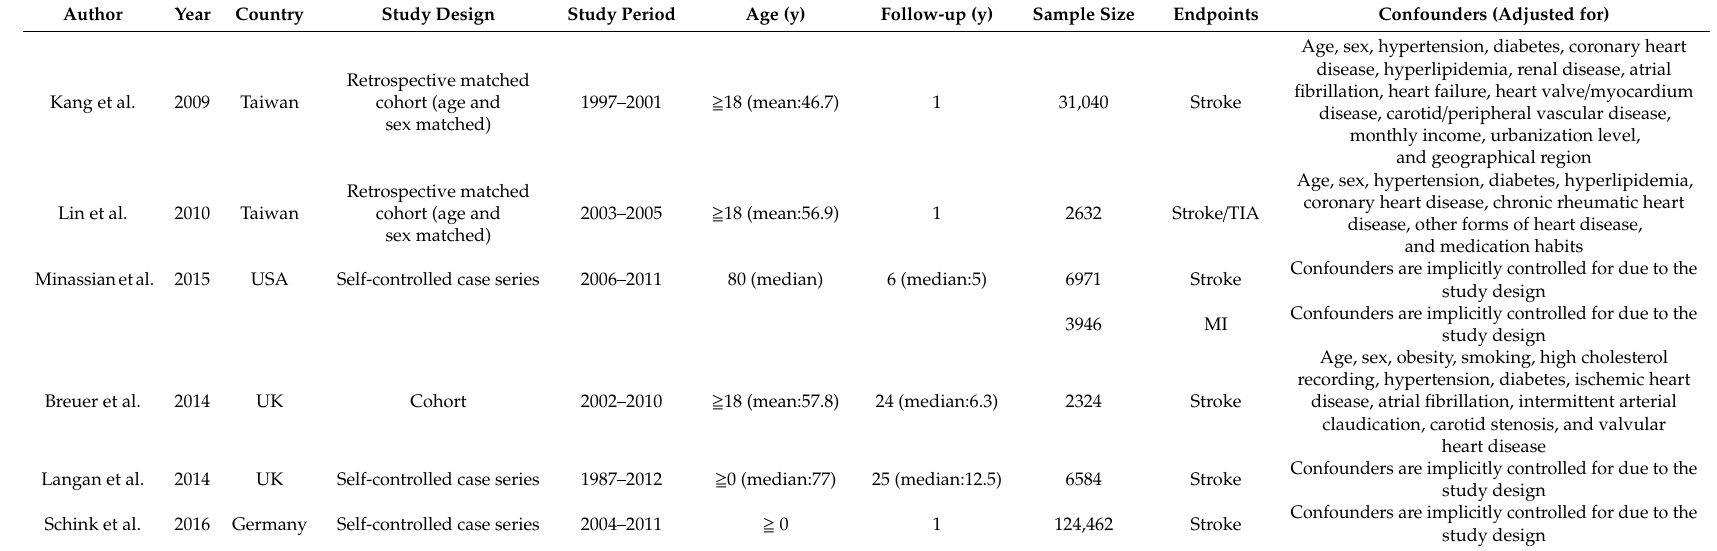
Table 3. Studies that investigated herpes zoster ophthalmicus and the risk of cardiovascular or cerebrovascular